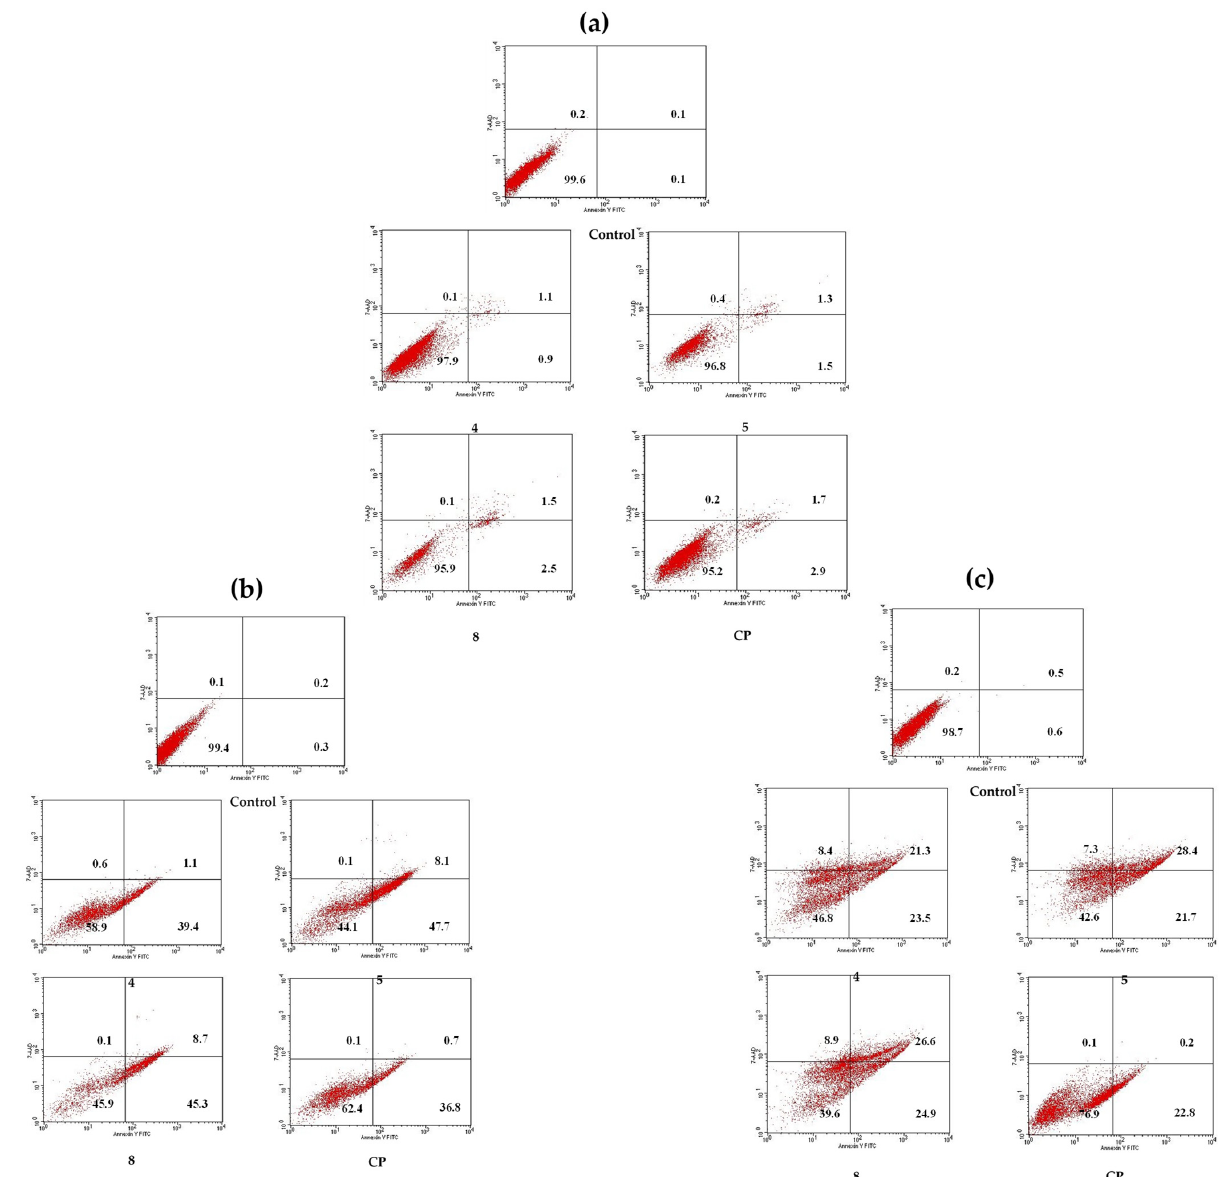
Figure 4. Representative results (%) as dot plots from apoptosis analysis of ( a ) RWPE-1, ( b ) LnCaP and ( c ) DU-145 cells after treatment with conjugates 4, 5 and 8 and free ciprofloxacin (CP) tested with flow cytometry. The lower right quadrant contains early apoptotic cells. The upper right quadrant represents late stage apoptotic